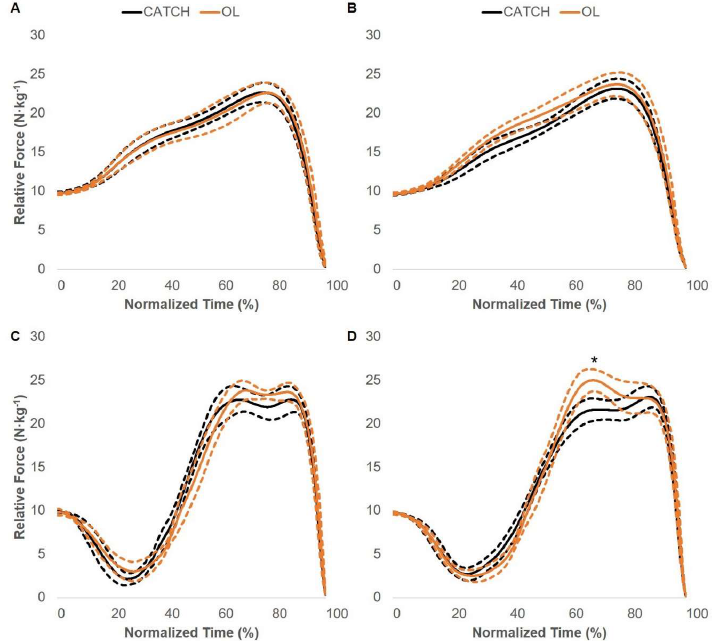
Figure 6. CATCH and OL group squat jump and countermovement jump force–time curve adaptations. Pre- ( A ) and post-intervention ( B ) squat jump force–time curve adaptations. Pre- ( C ) and post-intervention ( D ) countermovement jump force–time curve adaptations. Solid and dashed lines display the group average and 95% confidence intervals, respectively. * = statistically significant difference in relative force. J. Funct. Morphol. Kinesiol. 2020 , 5 , x FOR PEER REVIEW